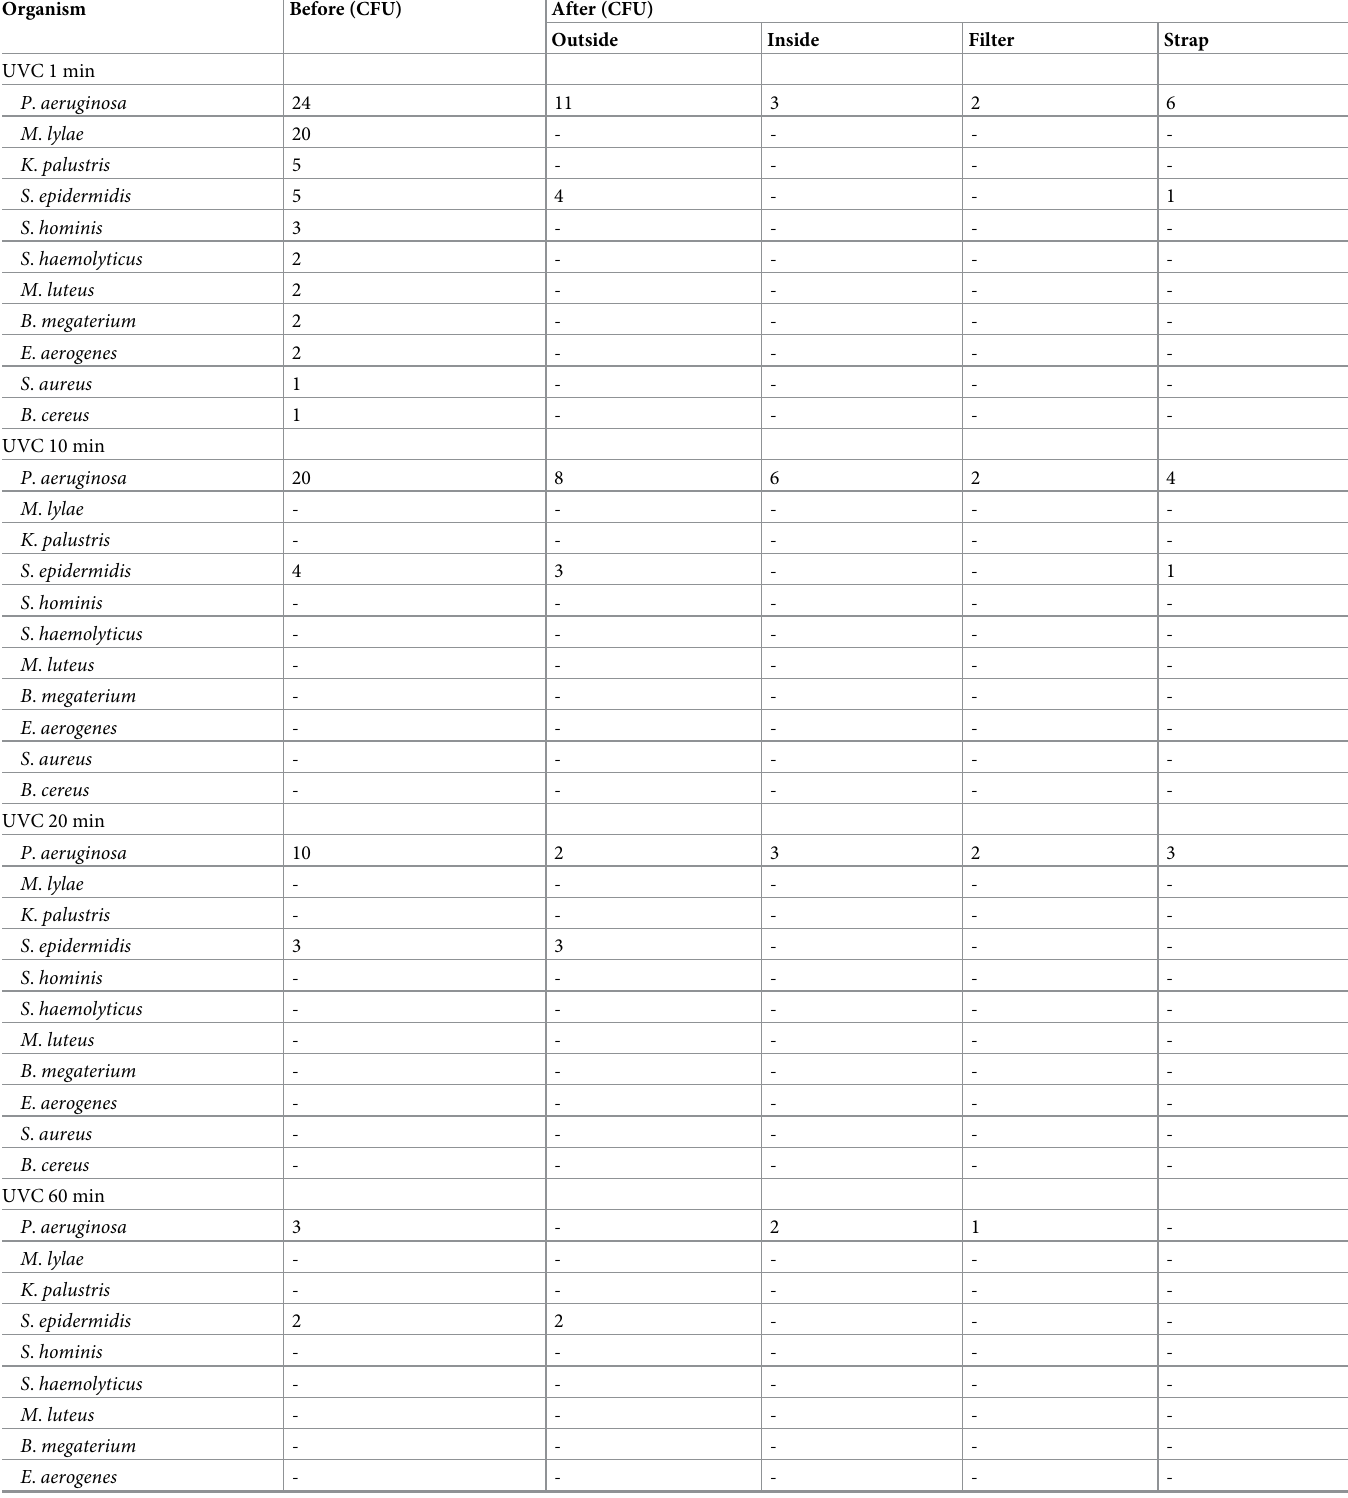
Table 2. The bacterial isolates and number of colony forming units recovered after UVC irradiation for the specified time.